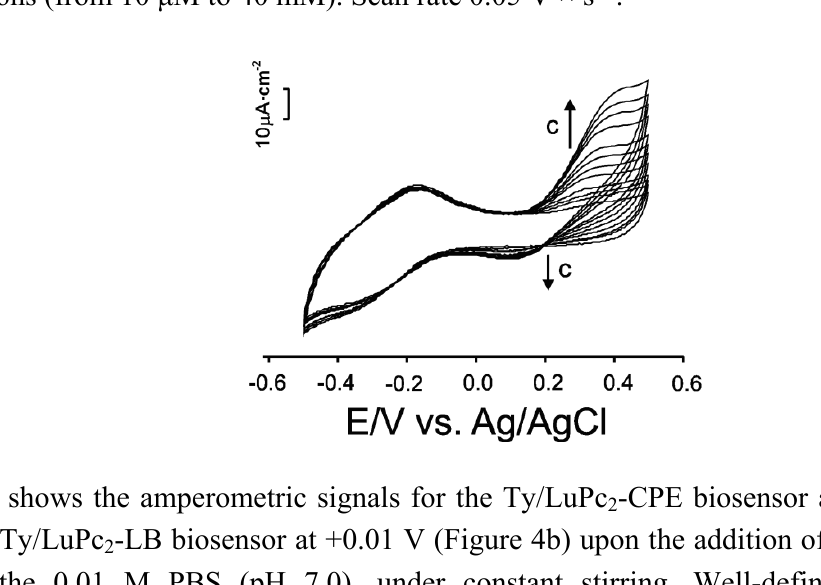
-CPE electrodes 2